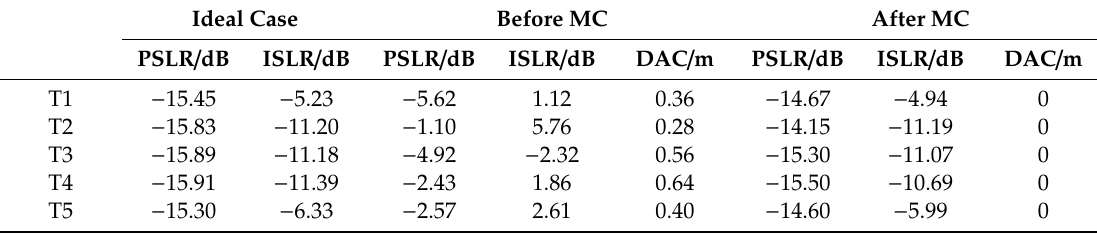
Table 5. Quality parameters with the sinusoidal perturbation.